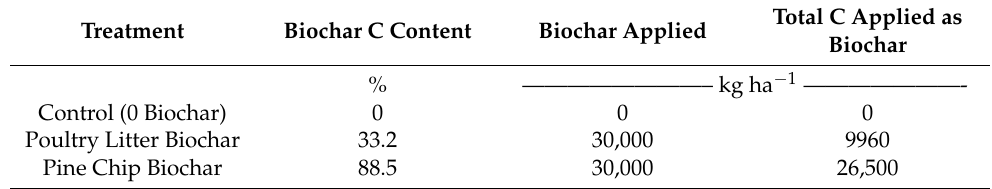
Table 3. Estimates of carbon (C) delivered by each treatment to the Goldsboro sandy loam soil. Treatment Biochar C